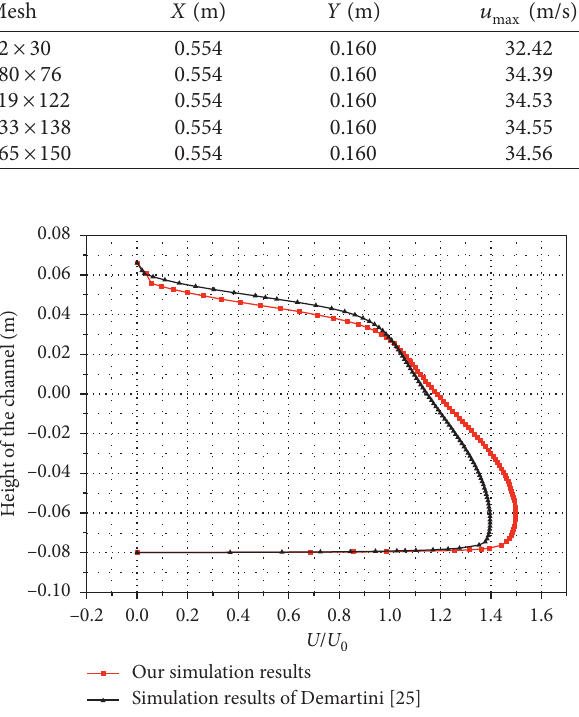
Figure 2: Axial velocity upstream of the first baffle at x � 0.159m.